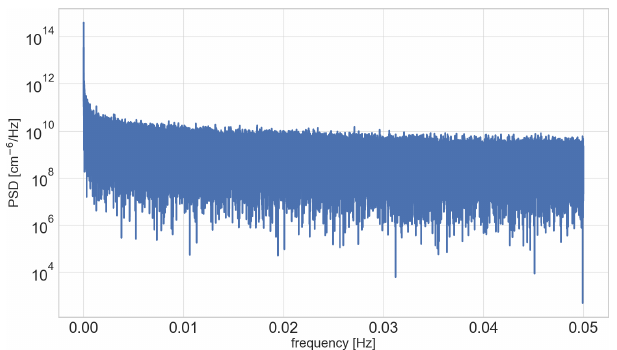
Figure B2. Power spectral density (PSD) of the particle number concentrations of the CPC3025 as a function of the frequencies. The dataset has a time resolution of 10s. For this figure we used the subset of the month of